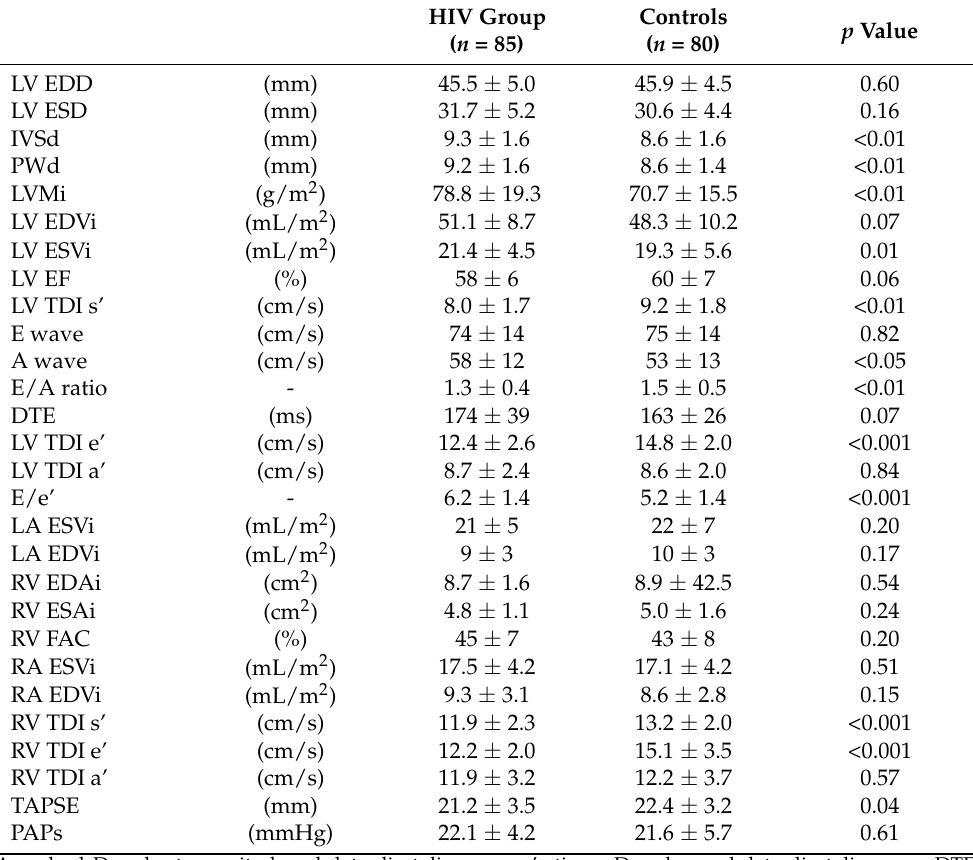
Table 2. Conventional echocardiographic